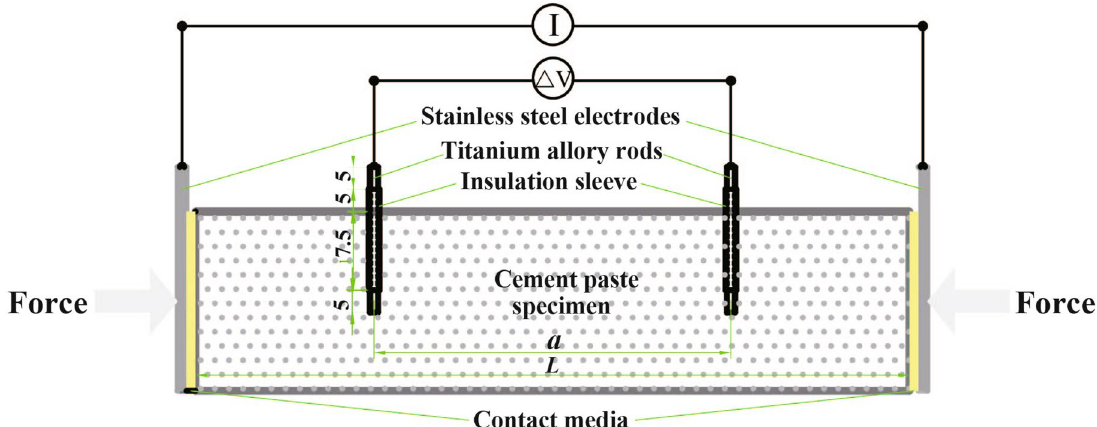
Figure 4. Cross-section of the four-point measurement ( L represents the length of the sample, a represents the center spacing of the voltage electrodes).